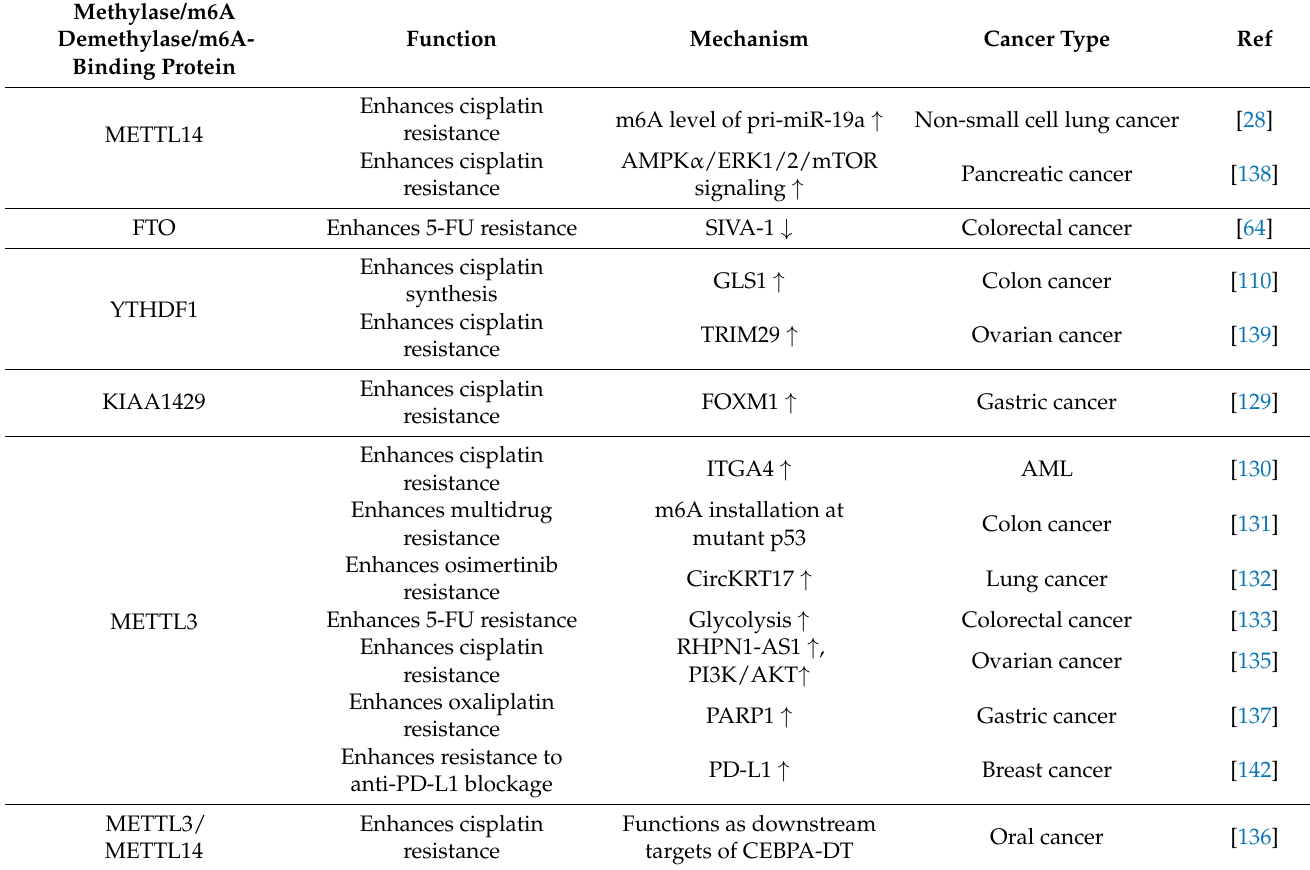
Table 4. Roles and targets of m6A regulators in anticancer drug